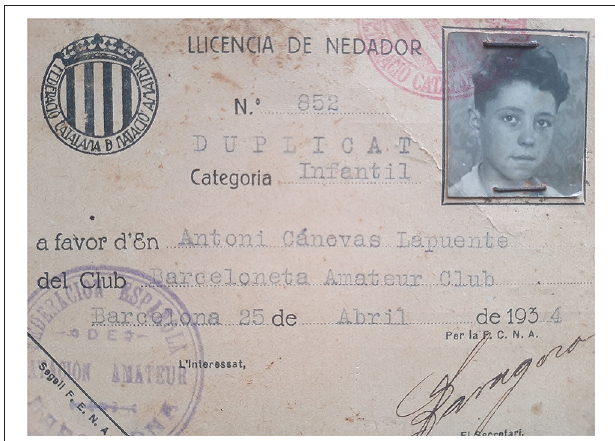
FIGURE 1 | Antonio Cánovas BAC swimmer’s license of children’s category (1934). Source: Cánovas family